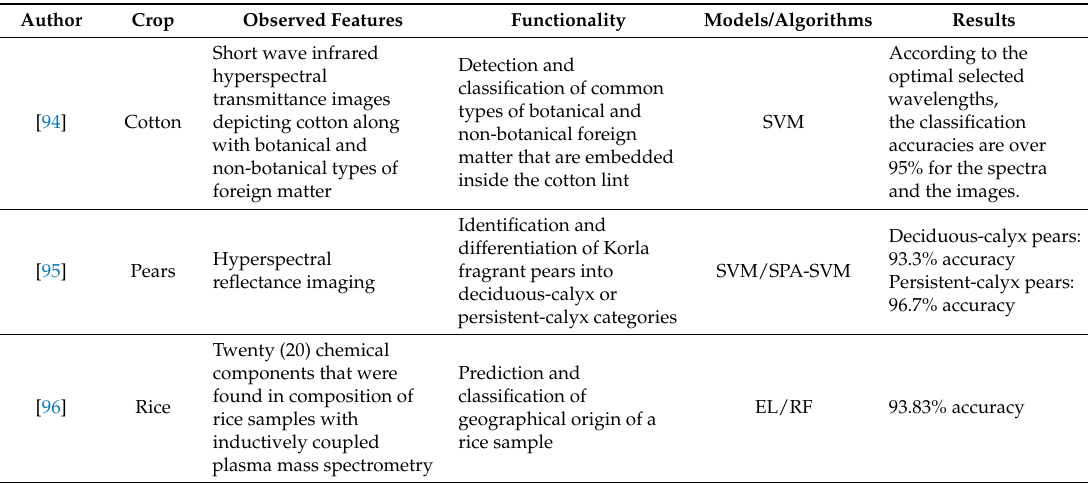
Table 8. Crop: crop quality table.